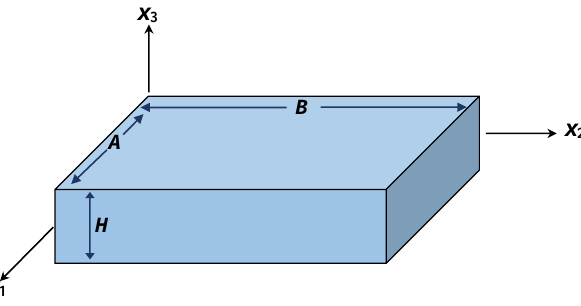
Figure 1. Configuration and coordinates of a porous nanocomposite plate.